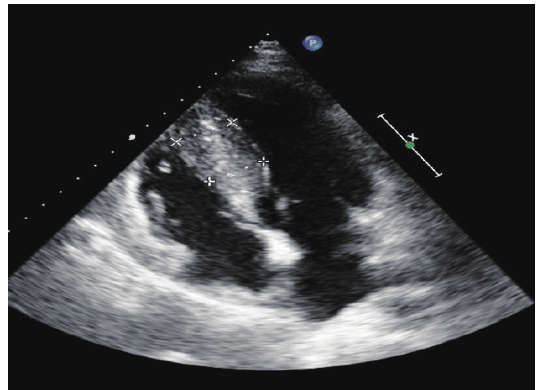
Figure 3 Apical four-chamber view: The basal and mid segments of ventricular septum are significantly thickened, with thicknesses of 25 mm and 25 mm, respectively.